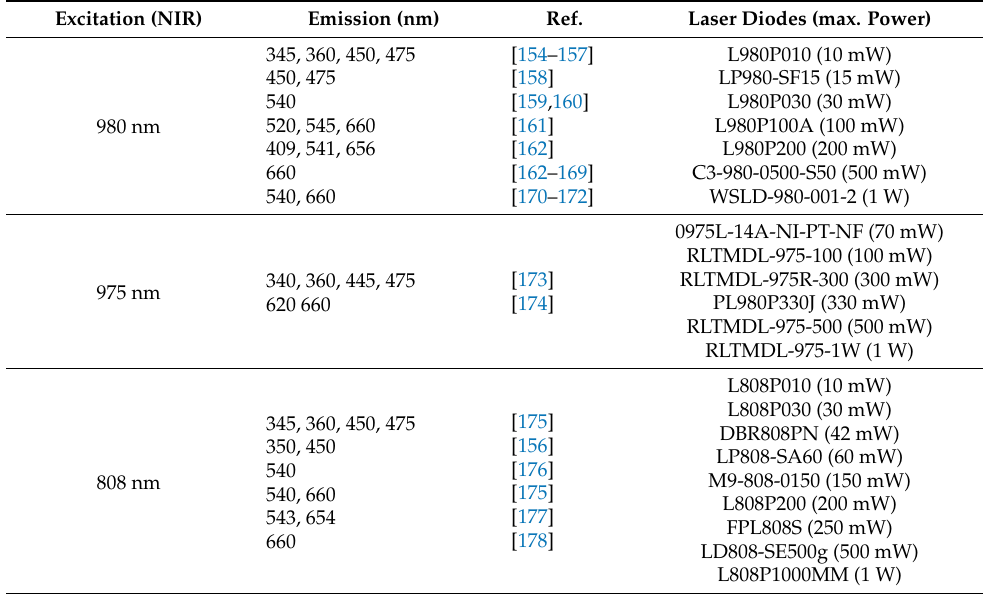
Table 3. Excitation and emission wavelengths of some reported UCNP, and available laser sources. Note UCNPs excited with 975–980 nm match a high absorption peak from water (Figure 1) which may cause excessive heating of the tissue. To overcome this, neodymium ions can be added to the UCNP which absorb ~800 nm [153].